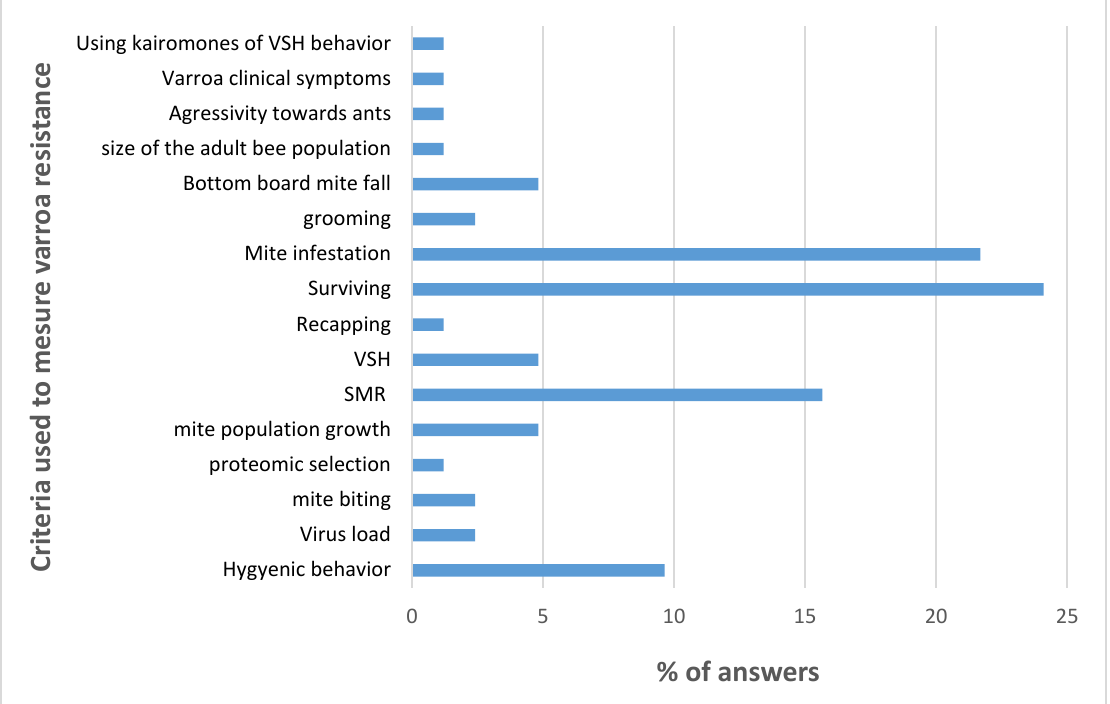
Figure 3. Criteria used for measuring varroa resistance. Data are presented as the percentage of breeders using each specific criterion.